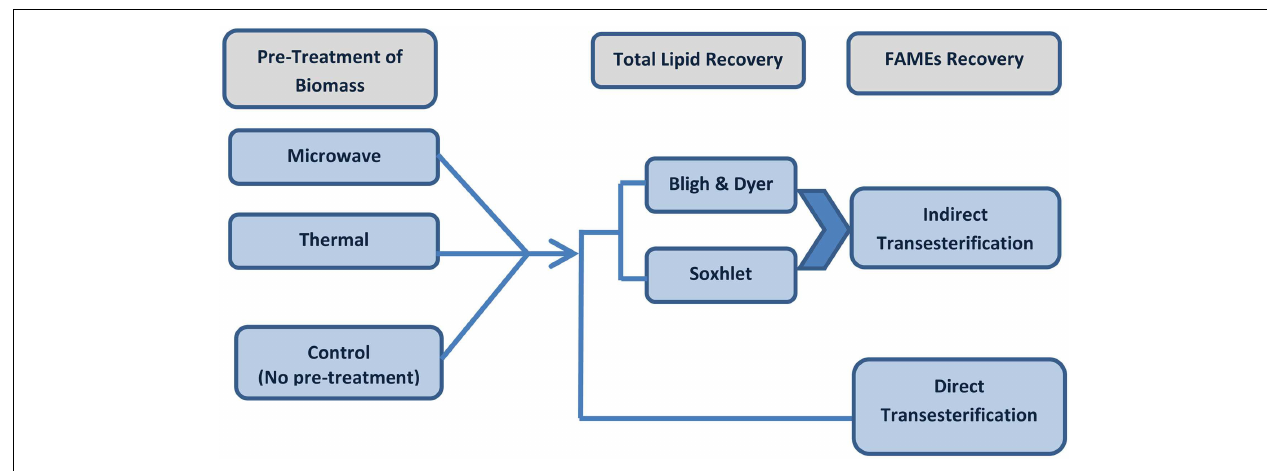
FIGURE 1 | Schematic experimental flow of pre-treated or untreated (control) algal biomass for lipid extraction followed by direct or indirect transesterification techniques .